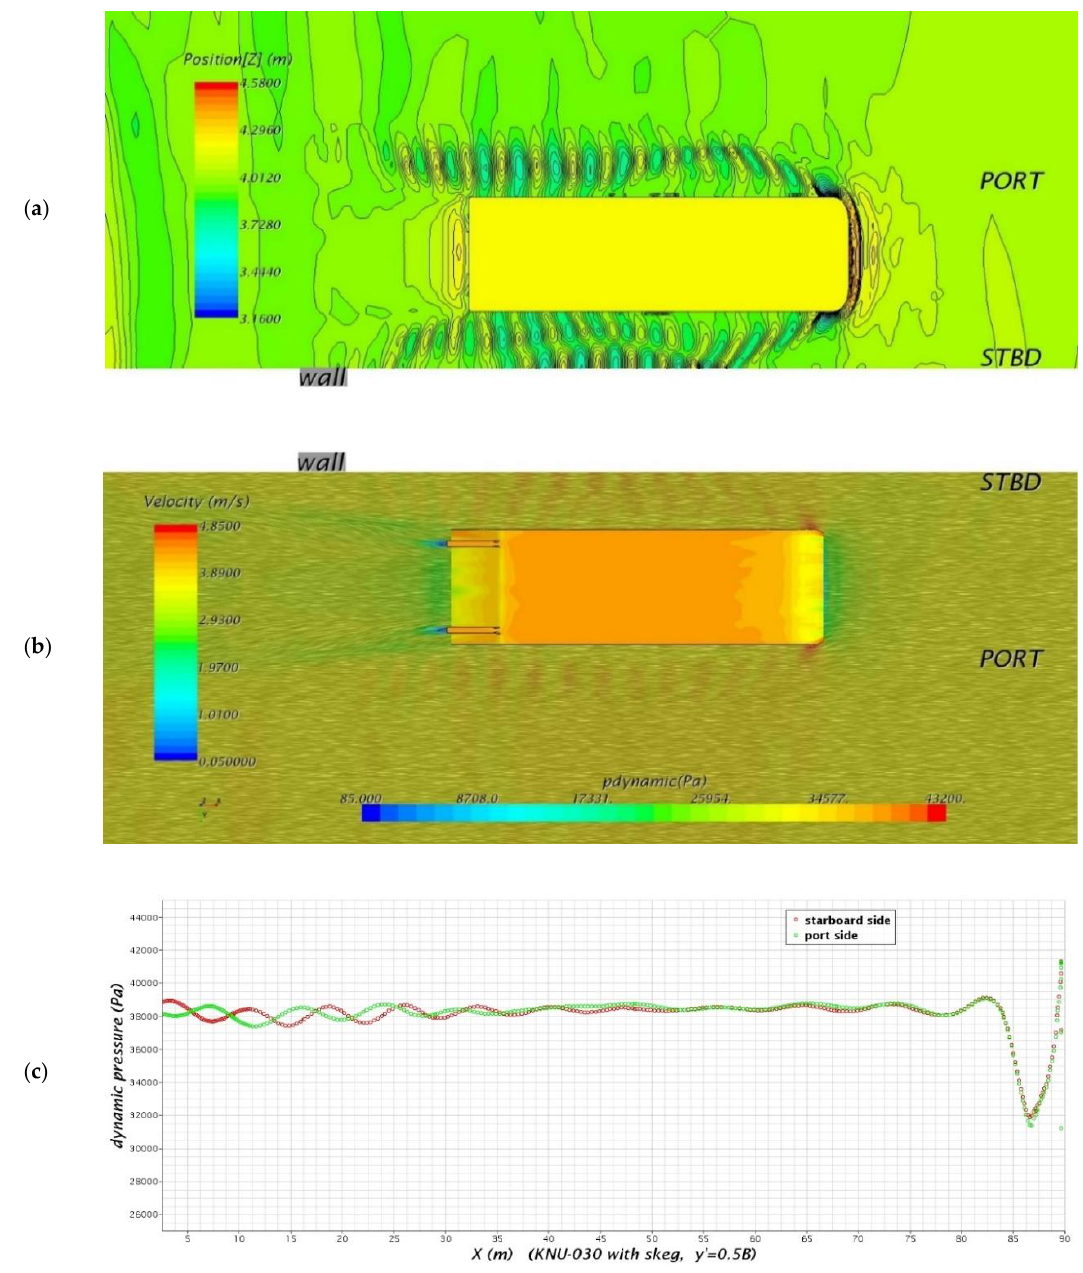
Figure 10. Simulation results for KNU-030 at y′ = 0.5 B : ( a ) wave pattern; ( b ) velocity field with line integral convolution and hydrodynamic pressure distribution on the bottom; and ( c ) hydrodynamic pressure on both starboard and port side.